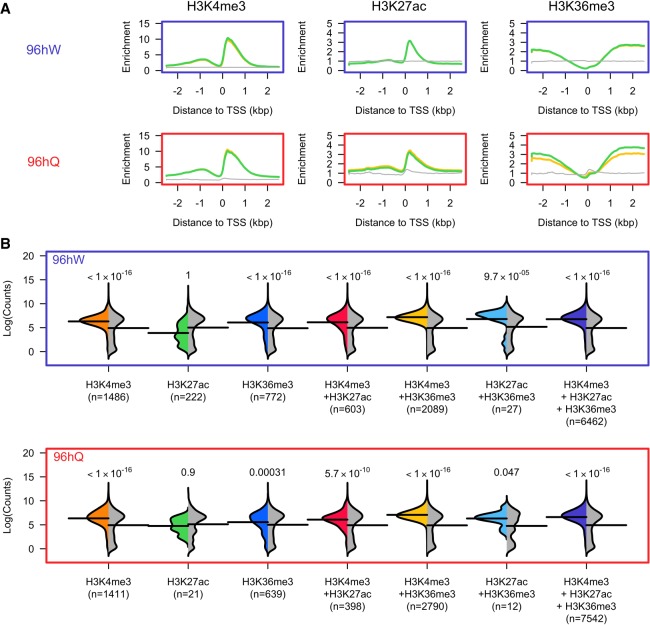
H3K4me3, H3K27ac, and H3K36me3 are associated with transcribed regions in honey bee castes. (A) Plots of the average ChIP-seq enrichment above input around the TSS (±2 kbp) of genes profiled across 96hW (upper) and 96hQ (lower). The green and yellow lines represent the two replicates performed for each ChIP-seq experiment, and the gray line represents the input. (B) The expression distribution (shown by a colored half-bean) of transcripts enriched by greater than threefold change above input for all possible combinations of H3K4me3, H3K27ac, and H3K36me3, compared to a random sampling of genes (gray half-bean). The mean of either distribution is shown by a solid black line; 96hW is shown in the top panel; 96hQ in the bottom panel; n is the number of transcripts.